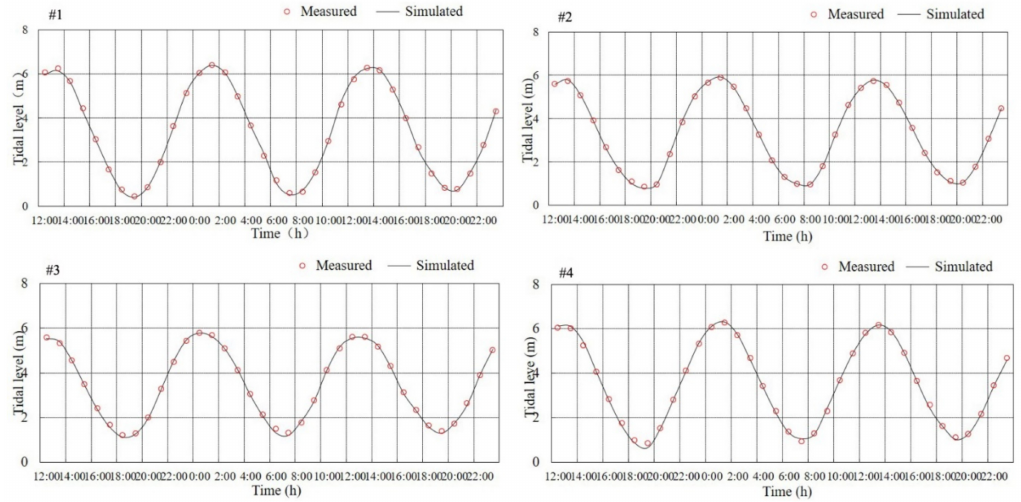
Figure 3. Validation map of spring tide level in April 2019 (local theoretical lowest tide